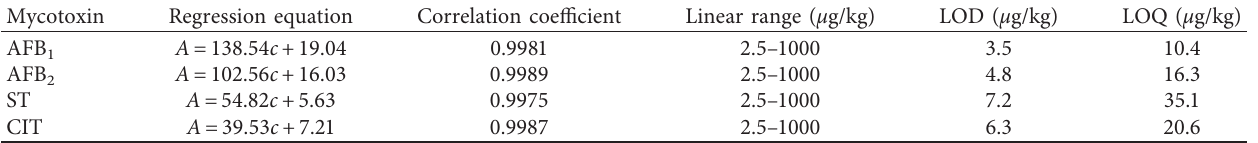
Table 1: Analytical performance.